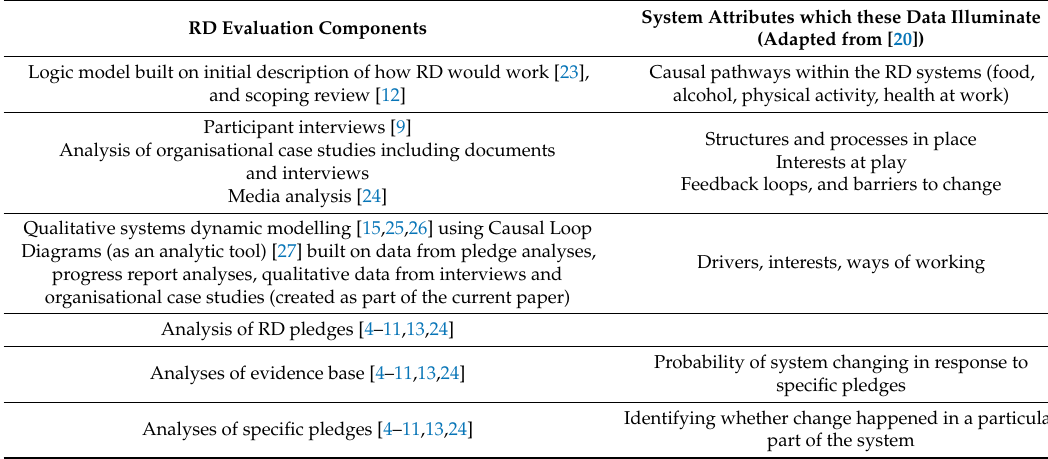
Table 1. Components of the Public Health Responsibility Deal (RD) evaluation, and aspects of the system which they shed light